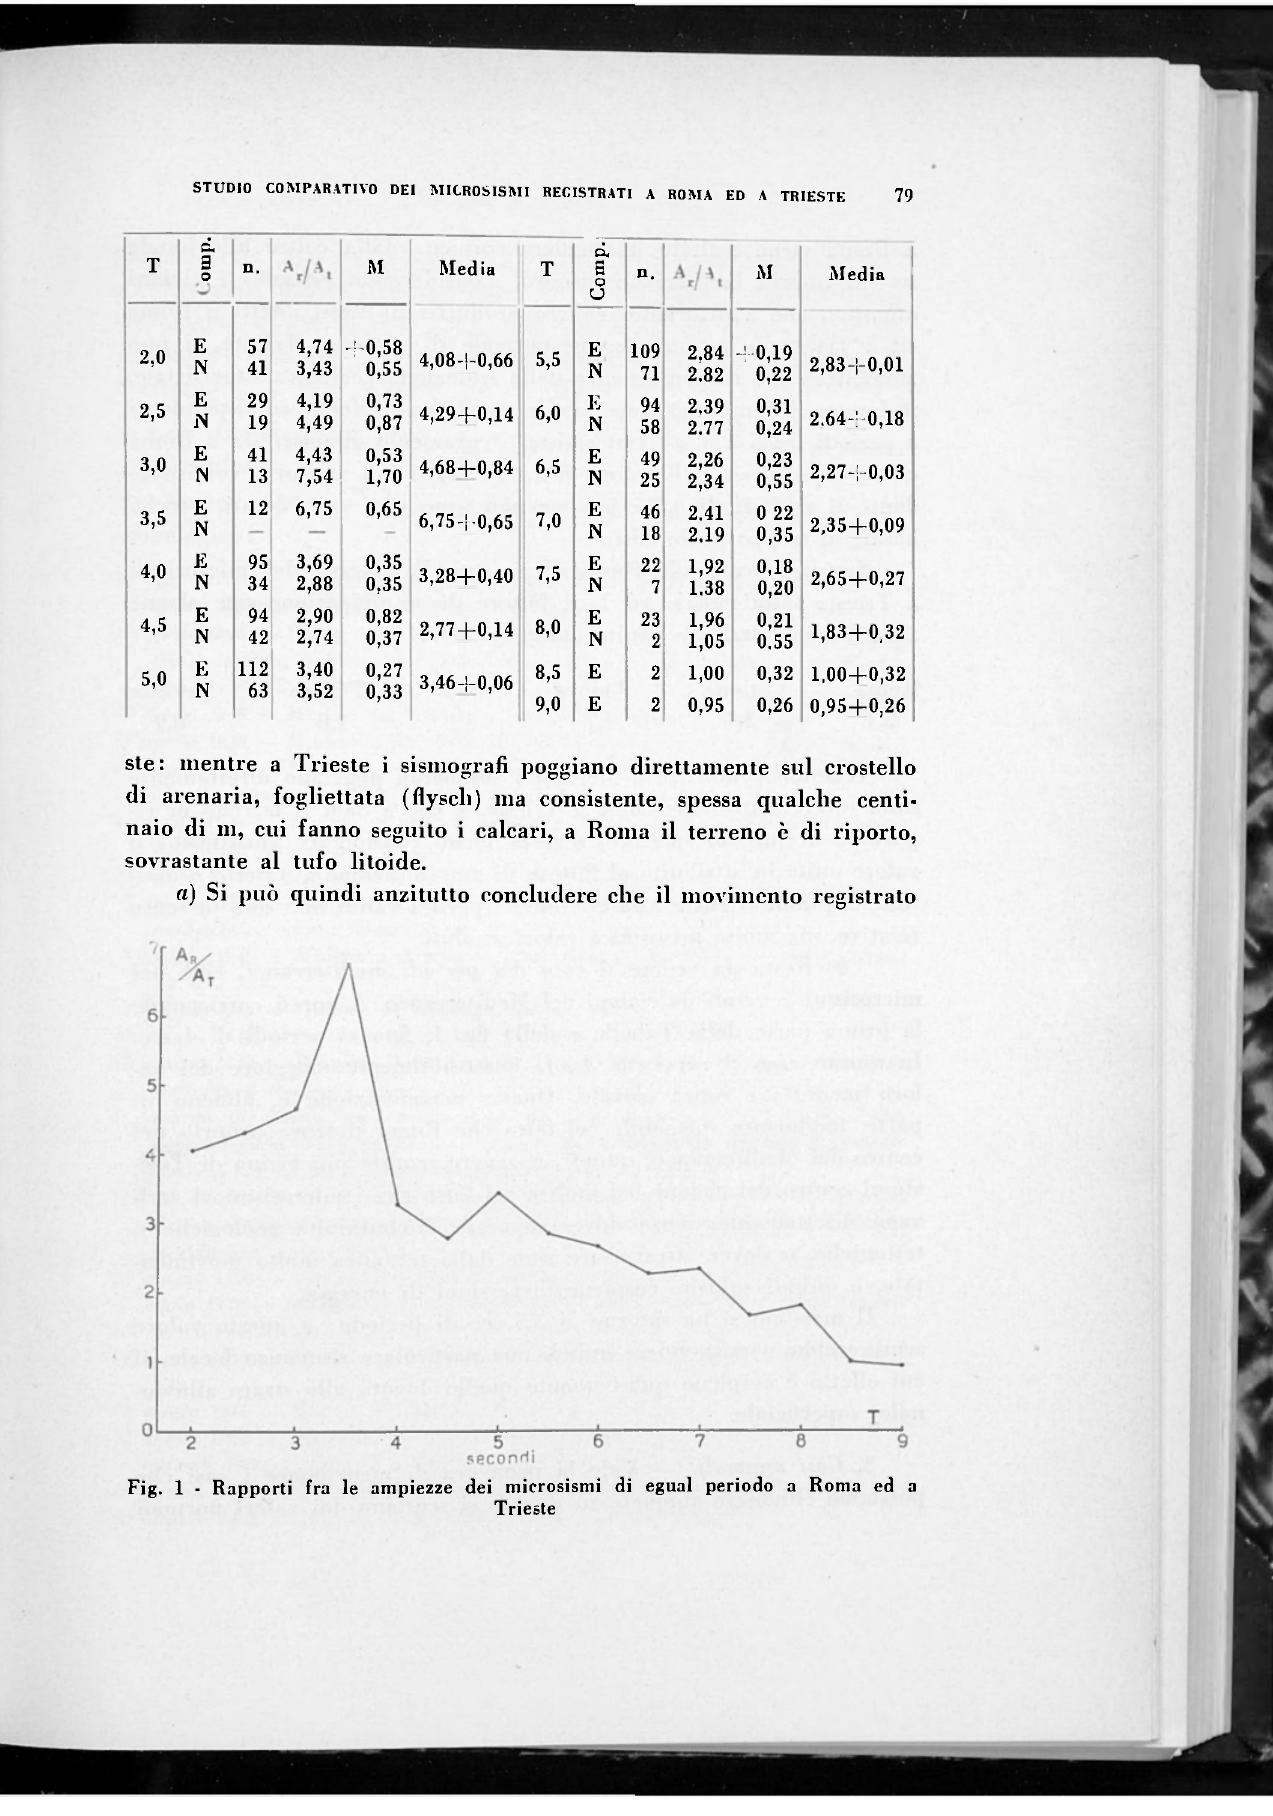
Fig. 1 - Rapporti fra le ampiezze dei microsismi di egual periodo a Roma ed a